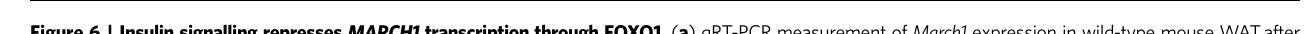
Figure 6 | Insulin signalling represses MARCH1 transcription through FOXO1. ( a ) qRT-PCR measurement of March1 expression in wild-type mouse WATafter 6h fasting (basal) or after 2h of insulin stimulation (clamp). n ¼ 8 (basal) and 9 (clamp) mice per group. ( b ) qRT-PCR measurements of MARCH1 expression ( n ¼ 3) in the indicated cell lines after acute insulin stimulation at the indicated doses. ( c ) qRT-PCR measurement of FOXO1 mRNA expression ( n ¼ 3) in HeLa cells expressing either a NS or FOXO1 shRNA. ( d ) qRT-PCR measurement of MARCH1 mRNA expression ( n ¼ 3) in HeLa cells expressing either a NS or FOXO1 shRNA. ( e ) qRT-PCR measurements of MARCH1 expression ( n ¼ 3) in HeLa (left) or HepG2 (right) cells expressing empty vector, wild-type FOXO1, constitutively active FOXO1 and/or PGC-1 a and treated with insulin as indicated. ( f ) Luciferase reporter assay ( n ¼ 3) for wild-type MARCH1 promoter (left) or a mutant MARCH1 promoter with a mutated FOXO1-binding site (right) in HeLa cells expressing empty vector, wild-type FOXO1, constitutively active FOXO1 ( FOXO1 CA ), and/or PGC-1 a and treated with insulin as indicated. ( g ) ChIP measurement of FOXO1 protein enrichment on the MARCH1 or ACTIN promoter with and without insulin treatment ( n ¼ 3) as indicated. Data are mean ± s.e.m. In all panels, * P o 0.05, comparisons by t -test. qRT-PCR, quantitative real-time